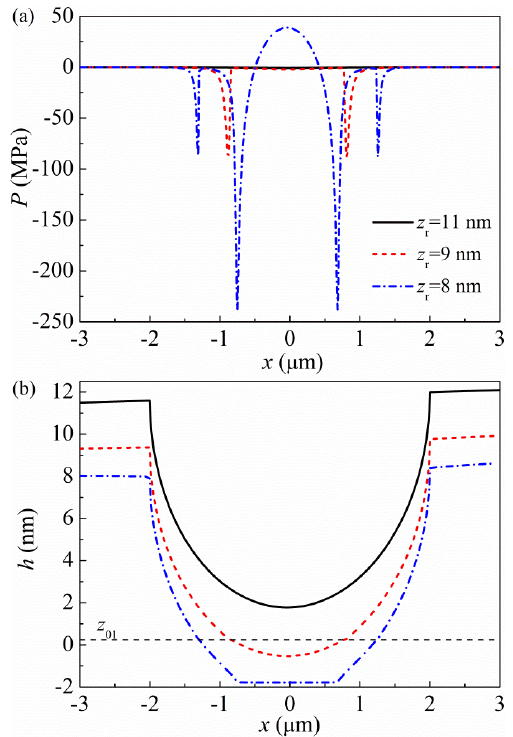
Figure 7. Pressure and distance distributions in the section of y = 0 at different operation states under l c = 10 nm, t lub = t DLC-disk = t DLC-slider = 2 nm: ( a ) Pressure P and ( b ) Height h .